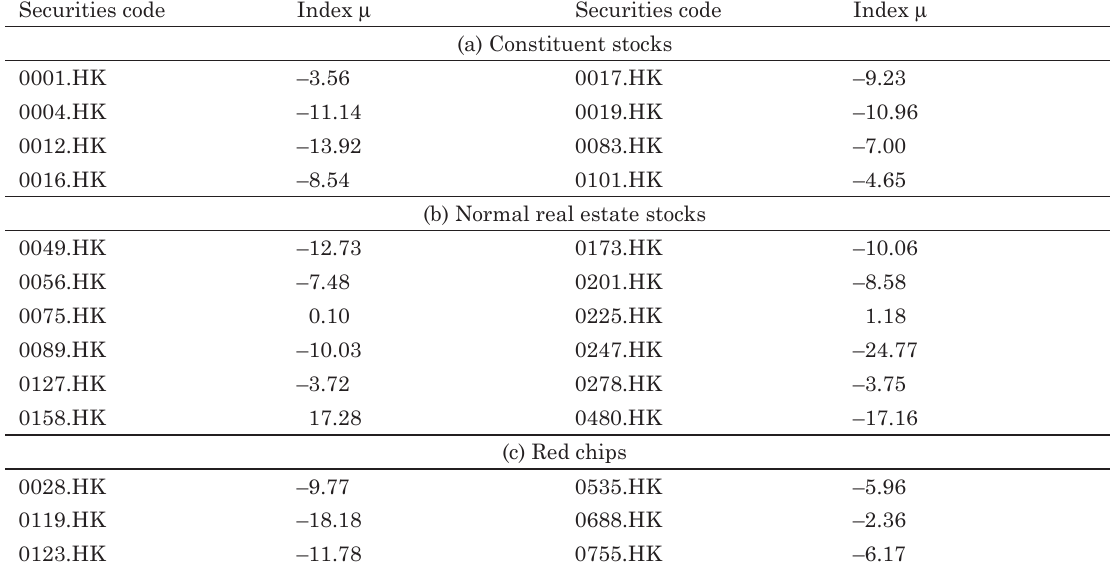
table 5. The shiryaev-Zhou index μ of Hong Kong real estate stocks